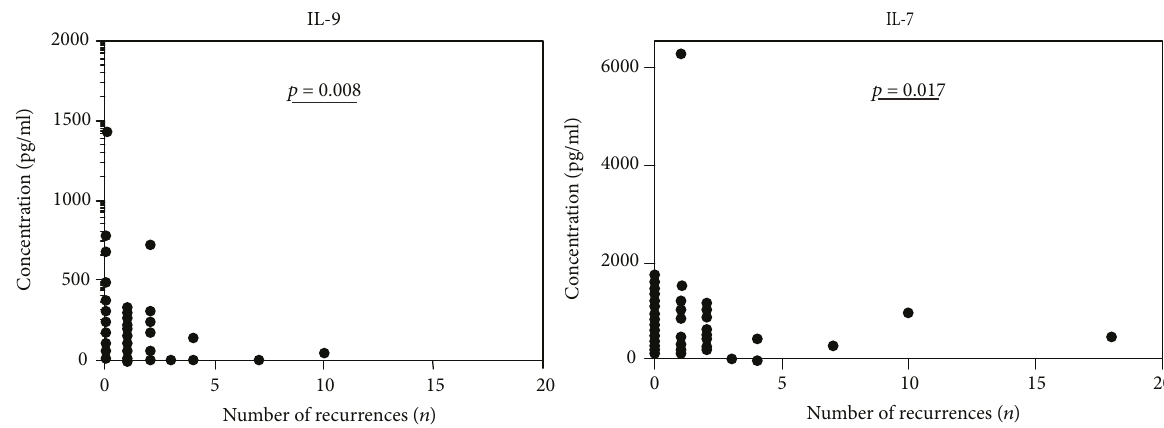
Figure 4: Correlation between cytokine levels and number of recurrences for IL-9 ( p = 0 008 ) and IL-7 ( p = 0 017 ) in aqueous humor of patients with pOT and rOT ( n = 51 ). A value of p ≤ 0 05 is de fi ned as statistically signi fi cant (Spearman correlation).